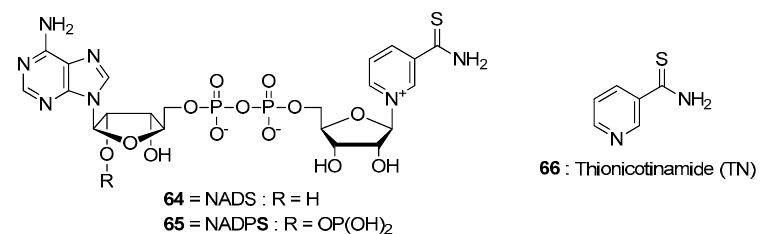
Figure 14. NAD analogs studied as NADK inhibitors inducing DHFR degradation [77] and G6PD inhibition [78].